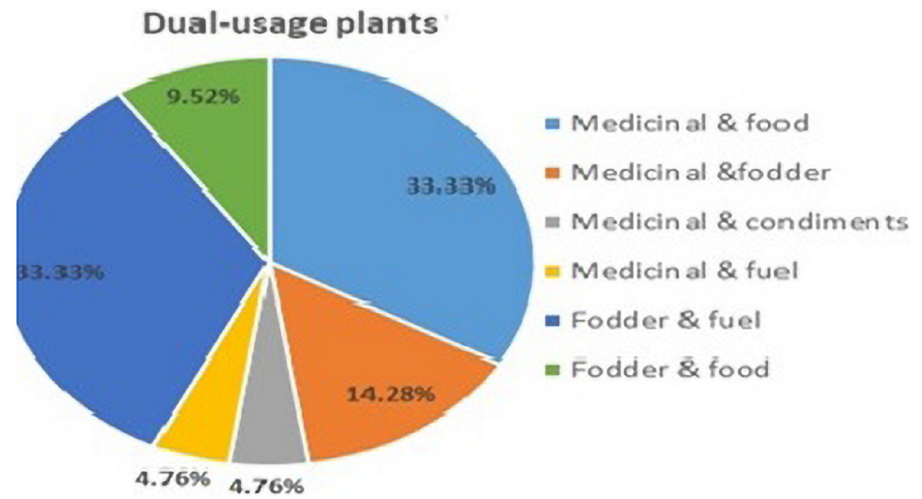
Fig 5. A pie-chart of dual usage plants the basis of their usage from study area of Dawarian and Rati Gali, District Neelam of Azad Jammu and Kashmir, Pakistan.